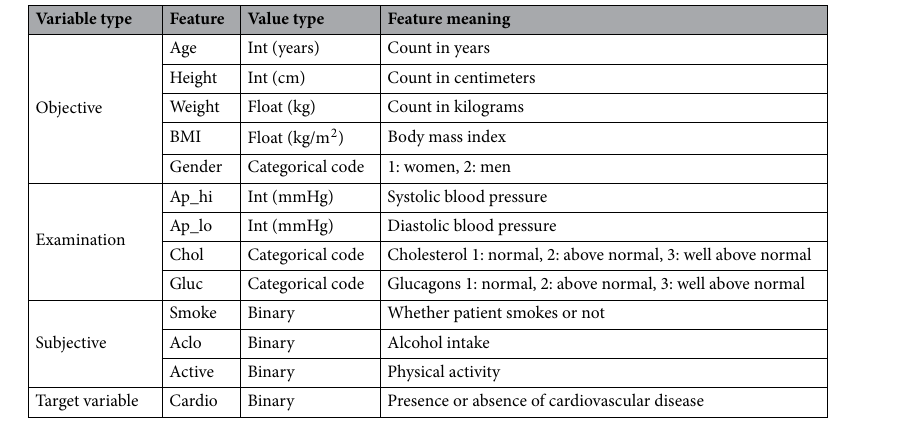
Table 4. Characteristics of the dataset. BMI = Height / (Weight *